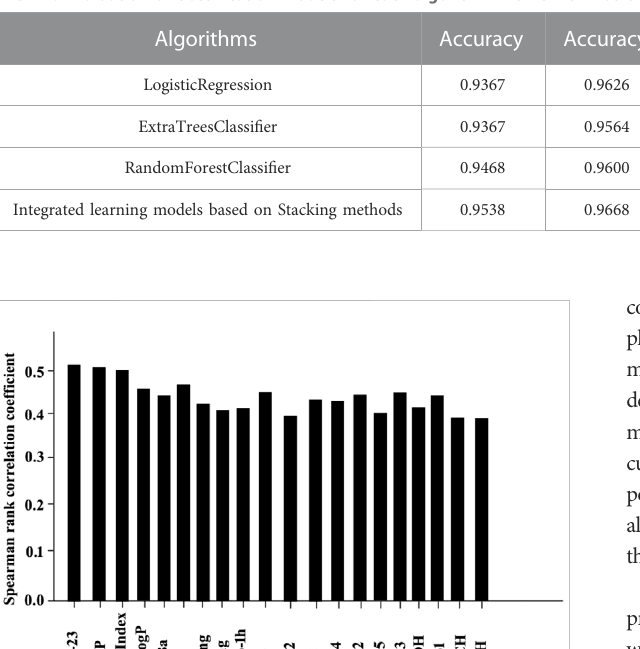
TABLE 6 Evaluation of classi fi cation models for each algorithm with CYP3A4 as the target value.